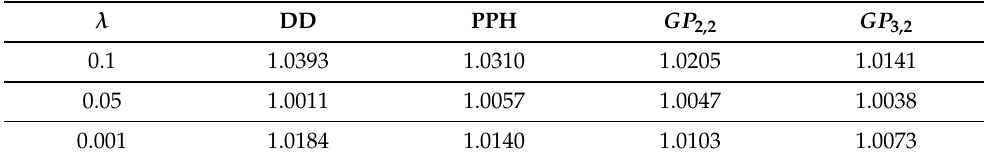
Table 1. Estimations of the stability constant in Theorem 2 for the DD, PPH and GP subdivision schemes after 15 levels of subdivision.